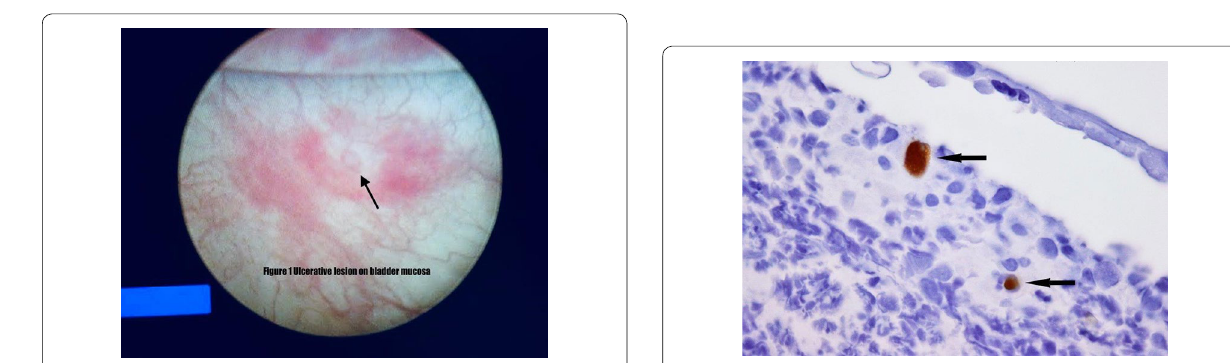
Fig. 3 H&E: 1000 magnification showing positive staining of × CMV-infected cells with CMV immunochemistry (black